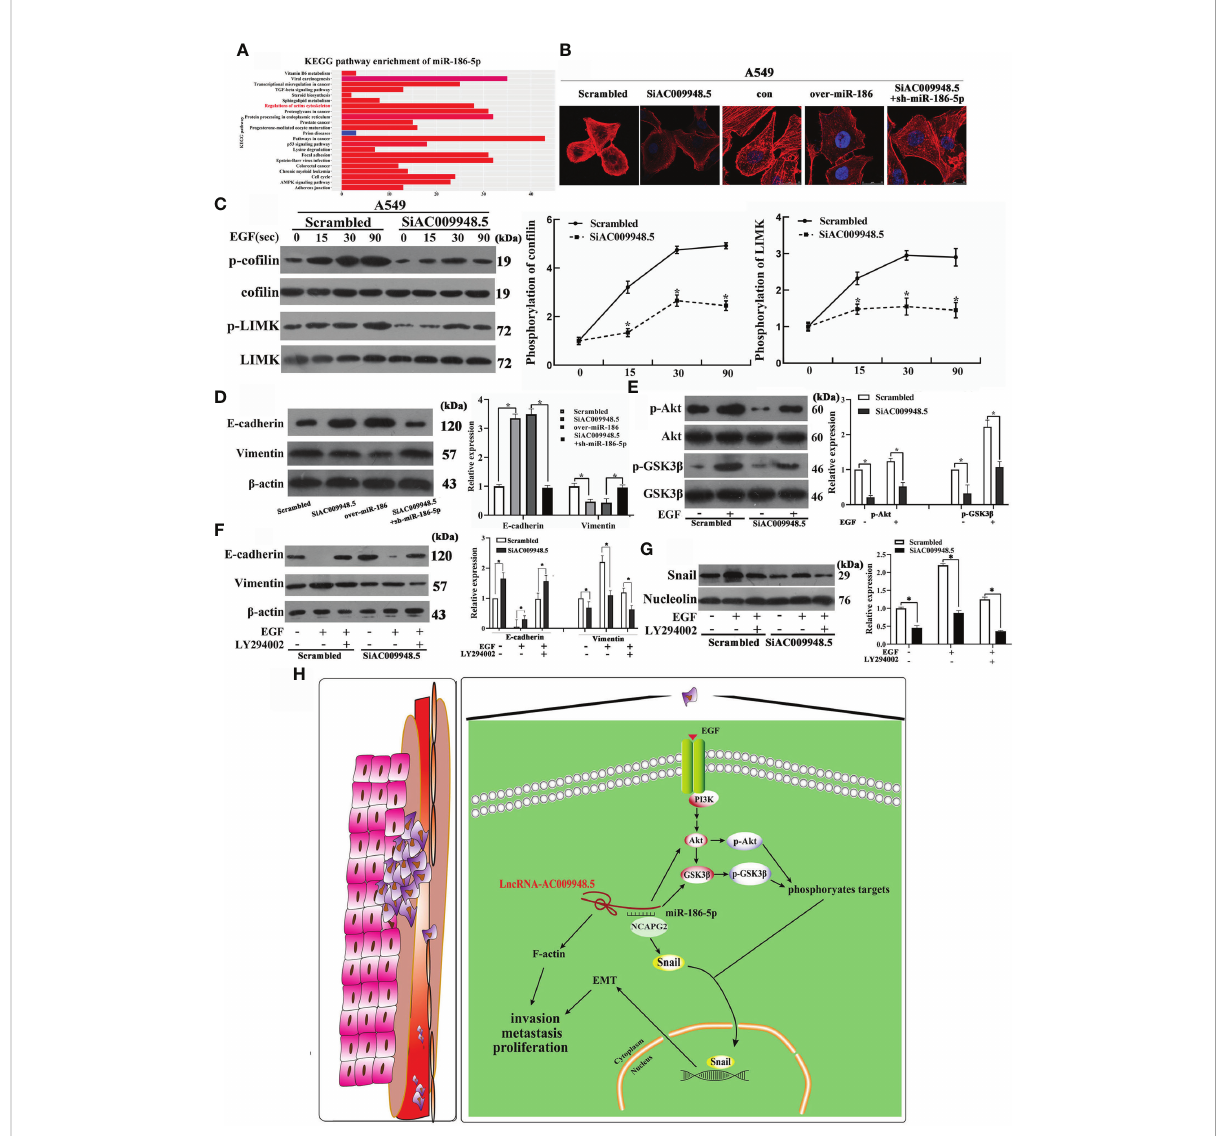
FIGURE 5 LncRNA-AC009948.5 promotes the occurrence of EMT by signaling pathways and the invasion and metastasis of lung adenocarcinoma cells. (A) KEGG analyses for miR-186-5p. (B) Observation of F-actin cytoskeleton by rhodamine-phalloidin staining in infected A549 cells. (C) Phosphorylation levels of co fi lin and LIMK were detected by Western blot after stimulation with EGF (100 ng/mL) for 0, 15, 30, and 90 seconds, respectively. (D) Expression levels of E-cadherin and Vimentin were detected by Western blot analysis. (E) Total protein was extracted from each group after stimulation with EGF (100 ng/mL). Phosphorylation levels of Akt and GSK3 b were detected by Western blot analysis. Akt and GSK3 b were used as a loading control. (F) The expression of EMT markers (E-cadherin, Vimentin) in infected cells was detected by Western blot analysis. b -Actin was used as a loading control. (G) The expression level of transcription factors (Snail) in the nucleus was detected by Western blot. Nucleolin was used as a loading control. The gray value is represented by a histogram. * P <0.05. All experiments were conducted independently three times. (H) The proposed model that LncRNA-AC009948.5 promotes the proliferation, invasion, metastasis, and EMT of lung adenocarcinoma by miR-186-5p binding and F-actin